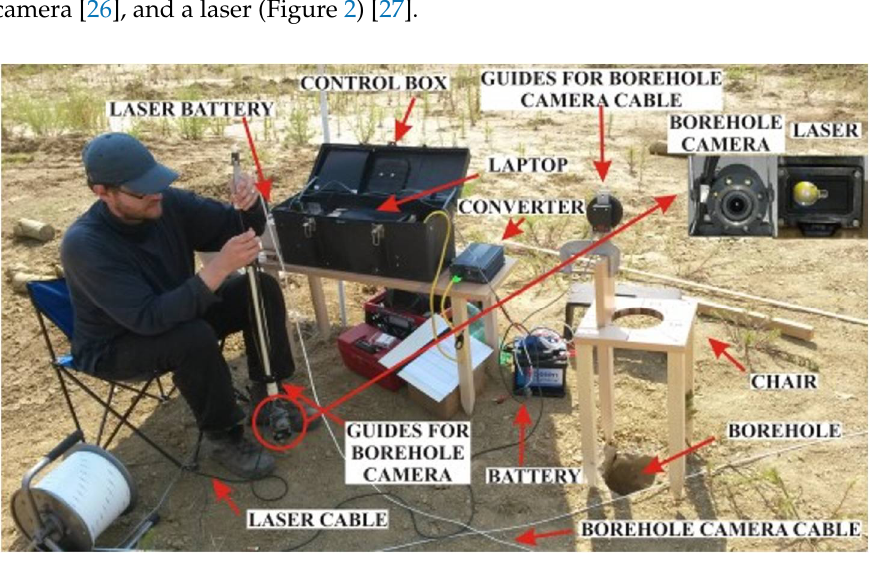
Figure 2. Developed integrated borehole camera laser system